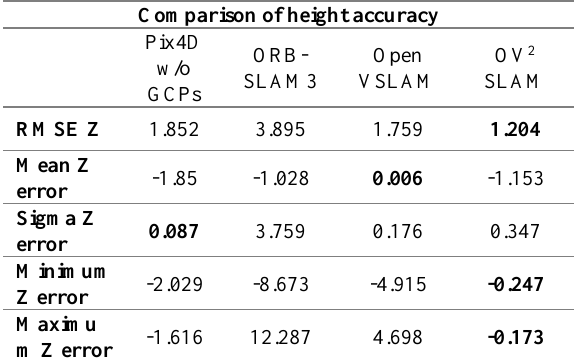
Table 9 Comparison of height accuracies between the reference surface model generated by Pix4D with ground control, the three real-time data products as well as the Pix4D reference data set without ground control Figure 5 depicts the surface models generated by OpenREALM as well as the reference model by Pix4D. The figure shows that the surface reconstruction quality varies heavily. The OpenVSLAM-based procedure returns an uneven and rough surface which results in issues of preserving straight geometries (cf. Figure 4). The DSM based on the ORB-SLAM3 implementation tilts towards lower heights in the eastern part which indicates a drift in scale. The reconstruction using OV 2 SLAM as a basis achieves the best representation of the